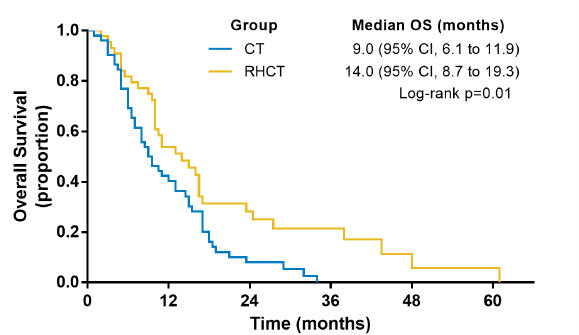
Figure 2: Survival curves of patients in RHCT and CT group. RHCT regional hyperthermia with chemotherapy; CT chemotherapy